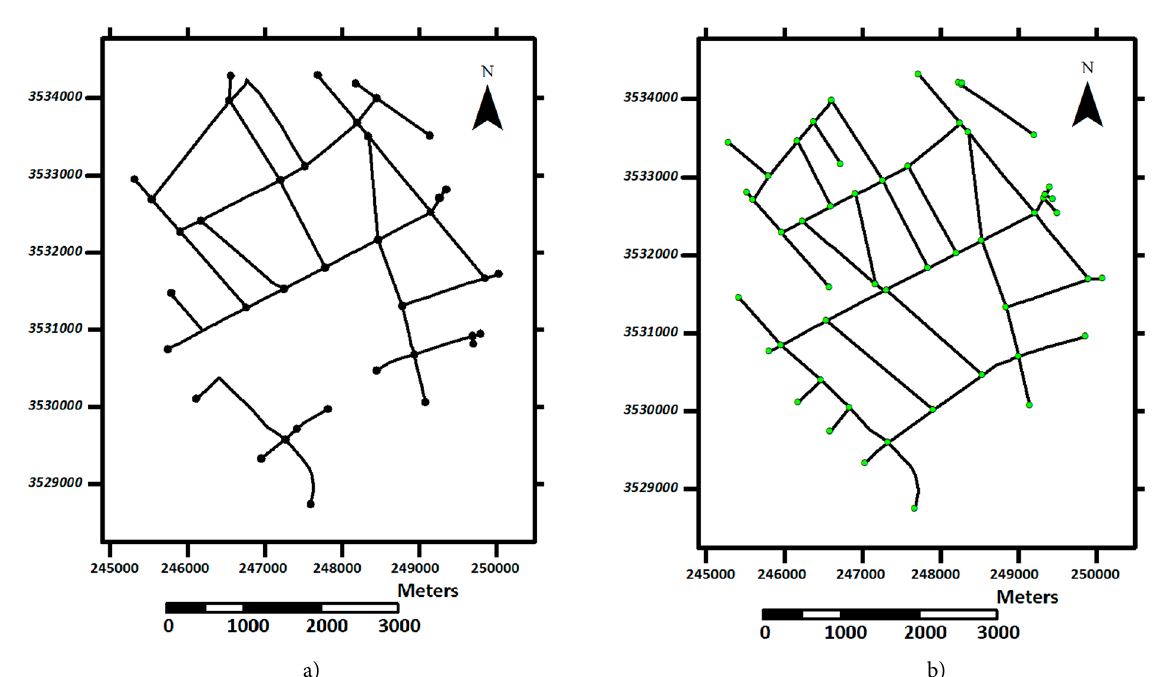
Fig. 17. Generated network for part of two datasets: a) – Reference dataset (1:25000); b) – Target dataset (1:5000)